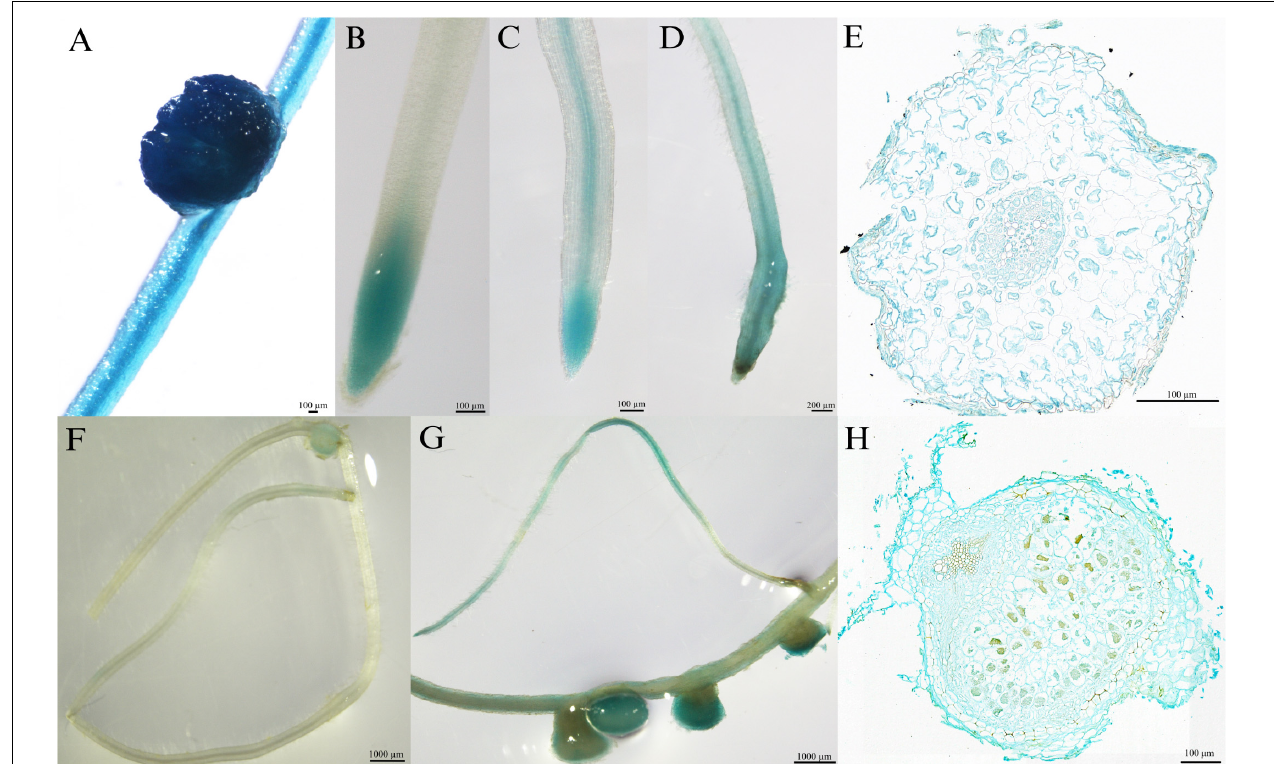
FIGURE 3 | Tissue-specific expression of MtPT6 in the roots and nodules of Medicago truncatula . (A) Expression of 35S promoter:: β -glucuronidase (GUS) in roots and nodules in the condition of normal inorganic phosphate (Pi) concentration (260 µ M). (B) Expression of proMtPT6 ::GUS in roots after hydroponic culture for 1 week. (C) Expression of proMtPT6 ::GUS in roots after hydroponic culture for 3 weeks. (D) Expression of proMtPT6 ::GUS in roots after low Pi treatment (5 µ M) for 1 week. (E) Cross section of root after low Pi treatment for 1 week. (F,G) Expression of proMtPT6 ::GUS in nodules in the condition of normal Pi concentration (260 µ M; F ) and low Pi concentration (5 µ M; G ). (H) Cross section of nodule after low Pi treatment. Bars = 200 µ m for (D) , 1,000 µ m for (F) and (G) , and 100 µ m for all other images.